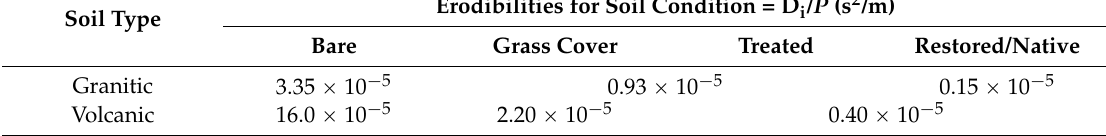
Table 12. Summary of stream power (Equation (20)) derived soil erodibility for granitic and volcanic soil RS plots from the southwest and north shores of Lake Tahoe,